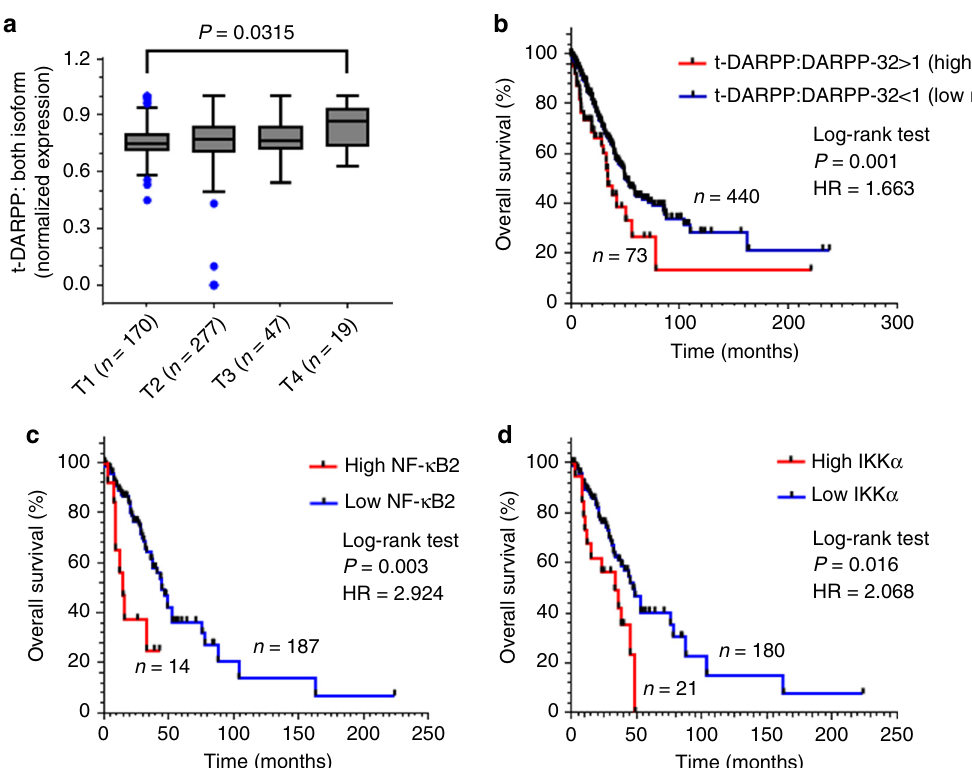
Fig. 8 Elevated t-DARPP, NF- ĸ B2 and IKK α transcripts correlate with decreased lung adenocarcinoma patient survival. a Quanti fi cation of t-DARPP mRNA expression in 513 human lung cancer tissue samples. Blue dots indicate outliers. T1 – T4 represents tumor (T) staging scores from TNM system. b Kaplan – Meier plot showing overall survival within the total cohort of 513 NSCLC patients based on the expression of t-DARPP and DARPP-32 mRNAs. c Kaplan – Meier curve depicting overall survival within the total cohort of 201 NSCLC patients based on the expression of NF- ĸ B2 or d IKK α mRNAs. The normalized read count for DARPP-32, t-DARPP, NF- ĸ B2 and IKK α mRNAs were obtained from The Cancer Genome Atlas dataset (TCGA). The difference between the two groups was calculated using log-rank (Mantel – Cox) test. HR hazard